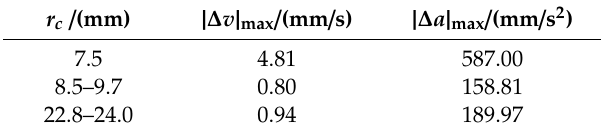
Table 3. Maximum amplitude of velocity and acceleration with di ff erent expanding radius.